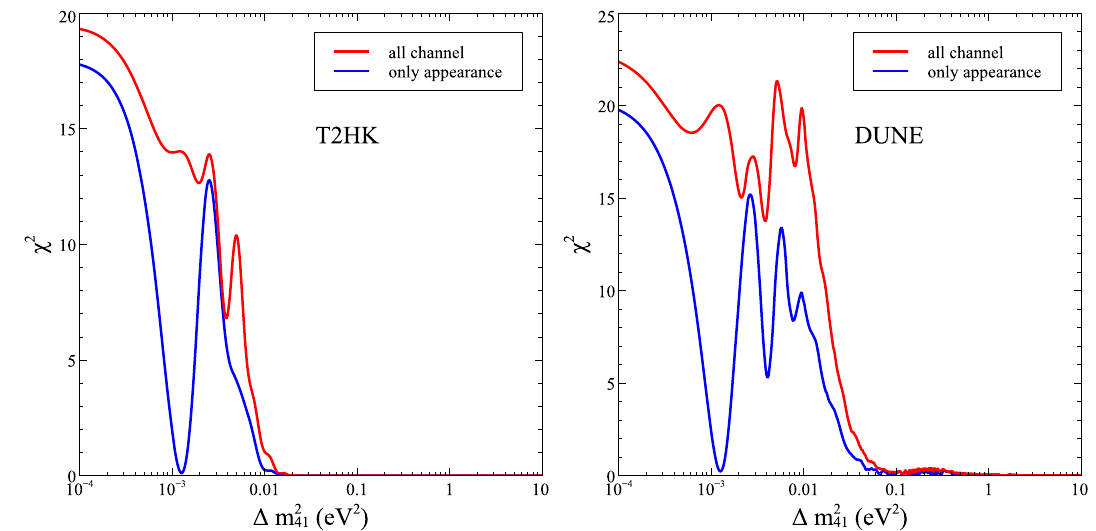
DUNE (right panel). The red lines show the corresponding χ 2 when 41 both disappearance and appearance data are taken together in the fit 41